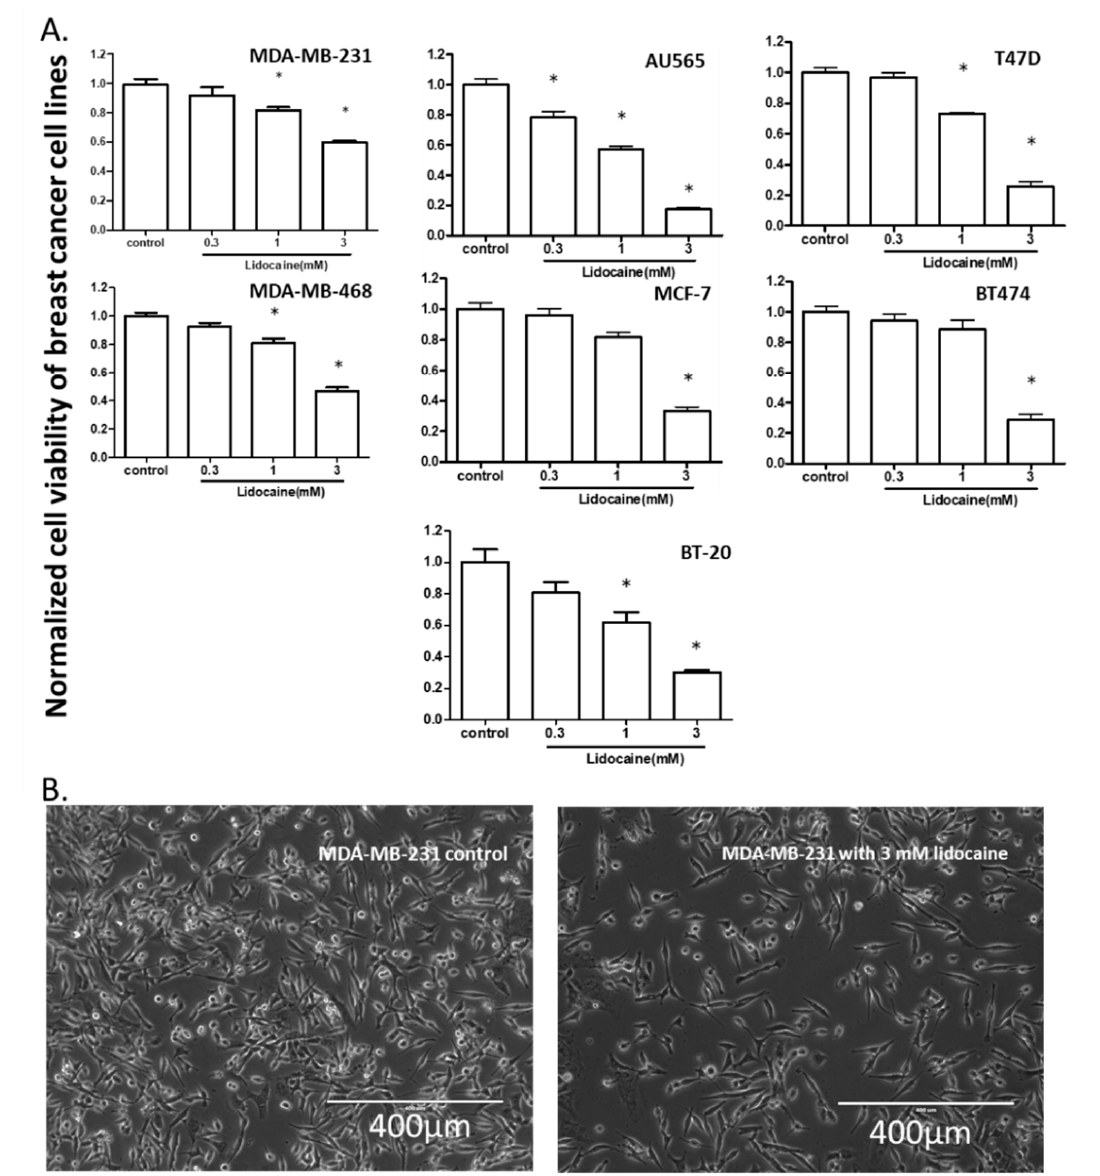
Figure 1. The effect of lidocaine on the viability of breast cancer cell lines. ( A ). Bar charts: [lidocaine] ≥ 0.3 mM inhibited AU565 viability, [lidocaine] ≥ 1 mM suppressed the viability of all cell lines except that [lidocaine] = 3 mM was needed for inhibition of BT474 and MCF-7 viability. “*” indicates the significant differences ( p < 0.05) compared with the control. ( B ). Representative image of cells after lidocaine exposure (MDA-MB-231).